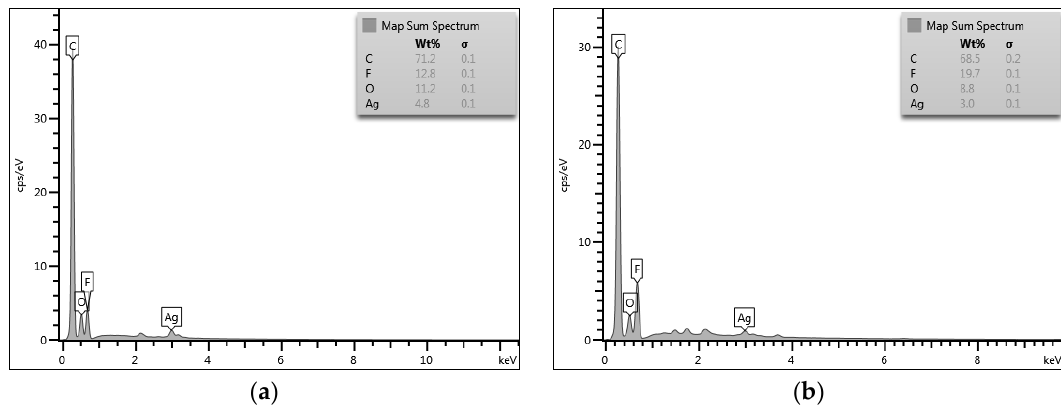
Figure 2. Energy dispersive X-ray (EDX) data of ( a ) Ag/PVDF-HFP and ( b ) Ag-MWCNTs/PVDF-HFP.